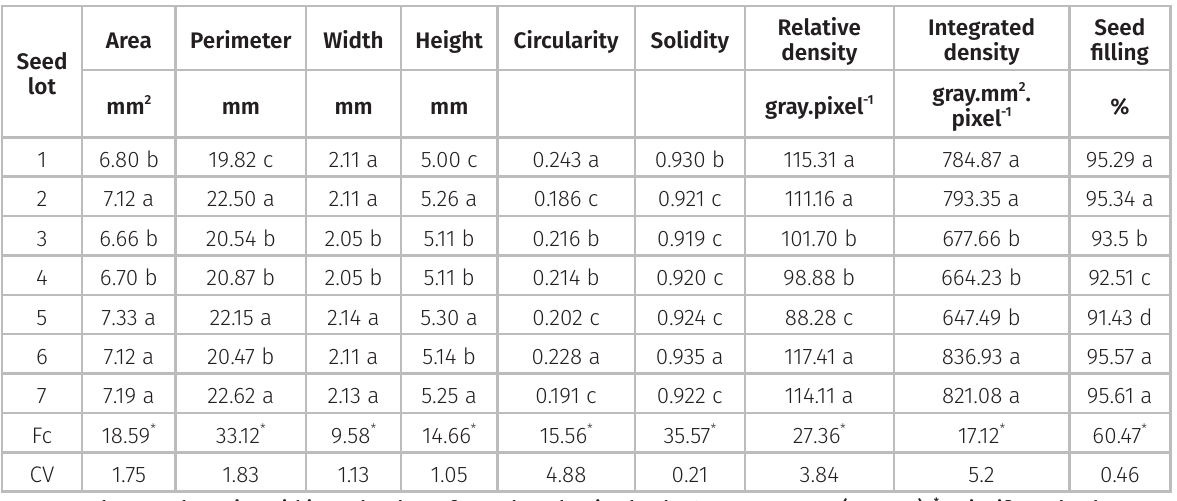
Table I. Mean values of morphometric data obtained by automated analysis of X-ray images of seven lot of Brachiaria ruziziensis seeds with use of the macro